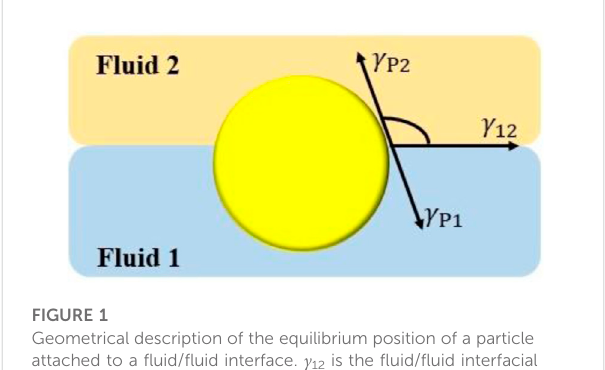
FIGURE 1 Geometrical description of the equilibrium position of a particle attached to a fl uid/ fl uid interface. γ 12 is the fl uid/ fl uid interfacial tension; γ P1 and γ P2 are the solid/ fl uid interfacial tensions between the particle and fl uid 1 and fl uid 2, respectively, and θ is the particle contact angle with the